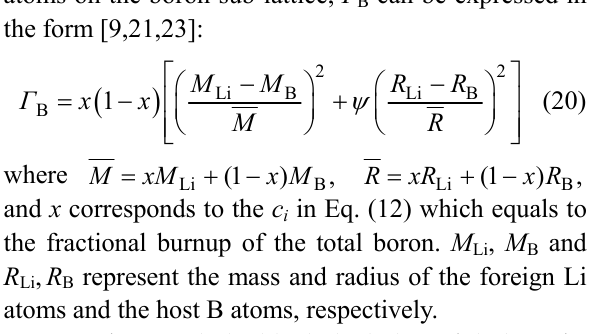
Fig. 1 Thermal conductivities of the unirradiated B 4 C pellets [3] fitted by different models. 1/ T model refers to the classical intrinsic thermal conductivity model represented by Eq. (5), while the minimum mean free path model corresponds to Eq.